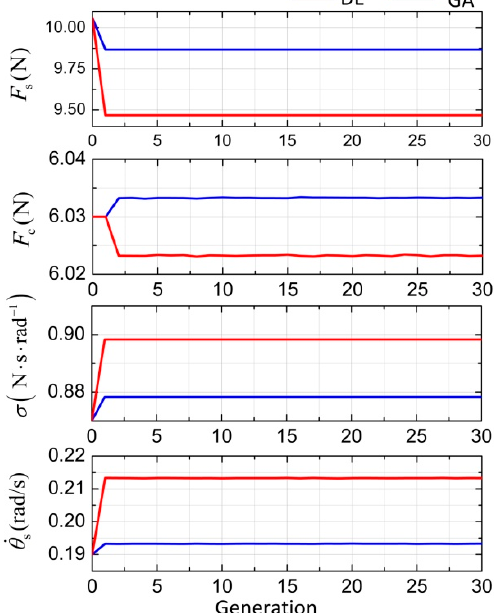
k and d p k in the positioning experiment.